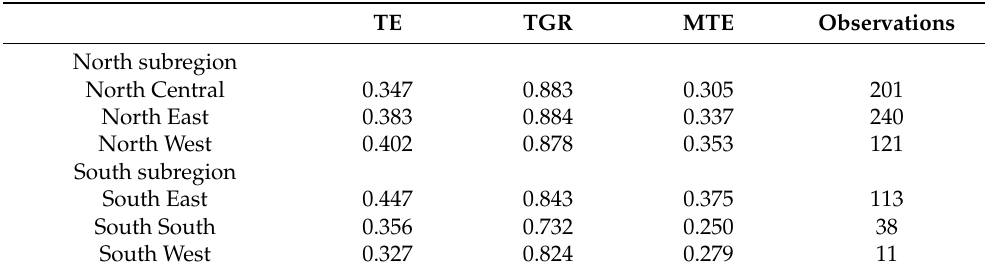
Table 5. Subregional sample average TE, TGR, and MTE. TE TGR MTE Observations North subregion North Central 0.347 0.883 0.305 201 North East 0.383 0.884 0.337 240 North West 0.402 0.878 0.353 121 South subregion South East 0.447 0.843 0.375 South South 0.356 South West